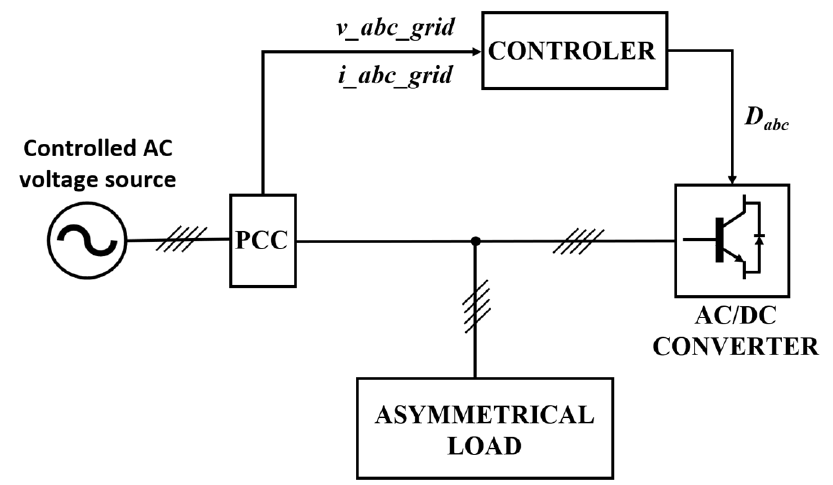
Figure 10. Test bench block diagram: three-phase AC/DC converter system for reactive power com- pensation.